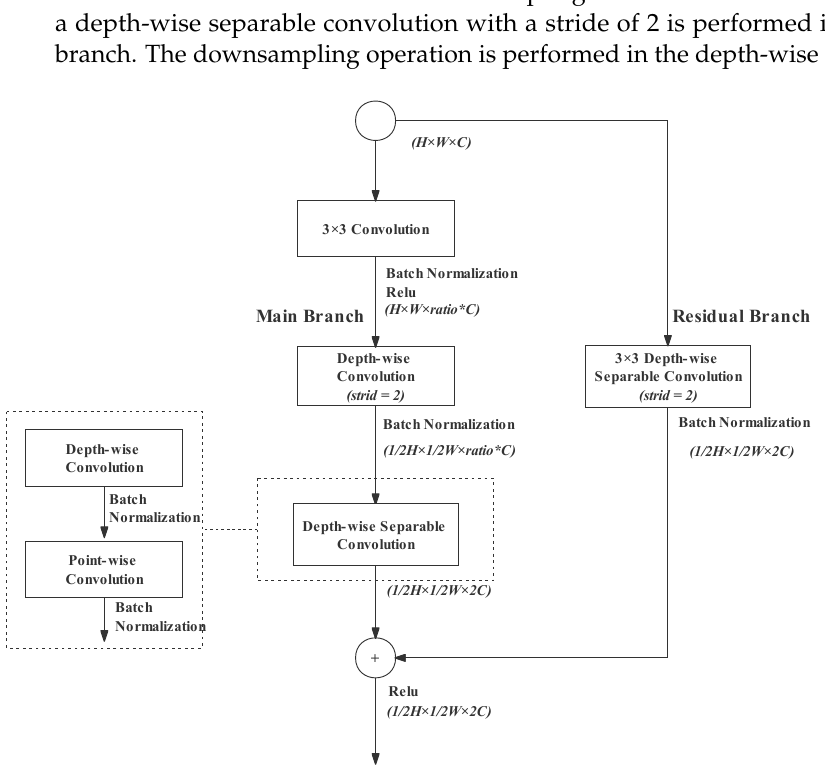
Figure 5. Gather-and-expansion bottleneck. Notation: the dotted area on the left explains the structure of the depth-wise separable convolution in the main branch. The ratio is 6 in practice. At the end of the GE bottleneck, two feature maps are added together. Moreover, since the continuous activation function undermines the feature representation, a ReLU activation function is performed only when the output feature map is concatenated. In summary, the GE bottleneck extracts feature representation and shrinks the feature size with fast